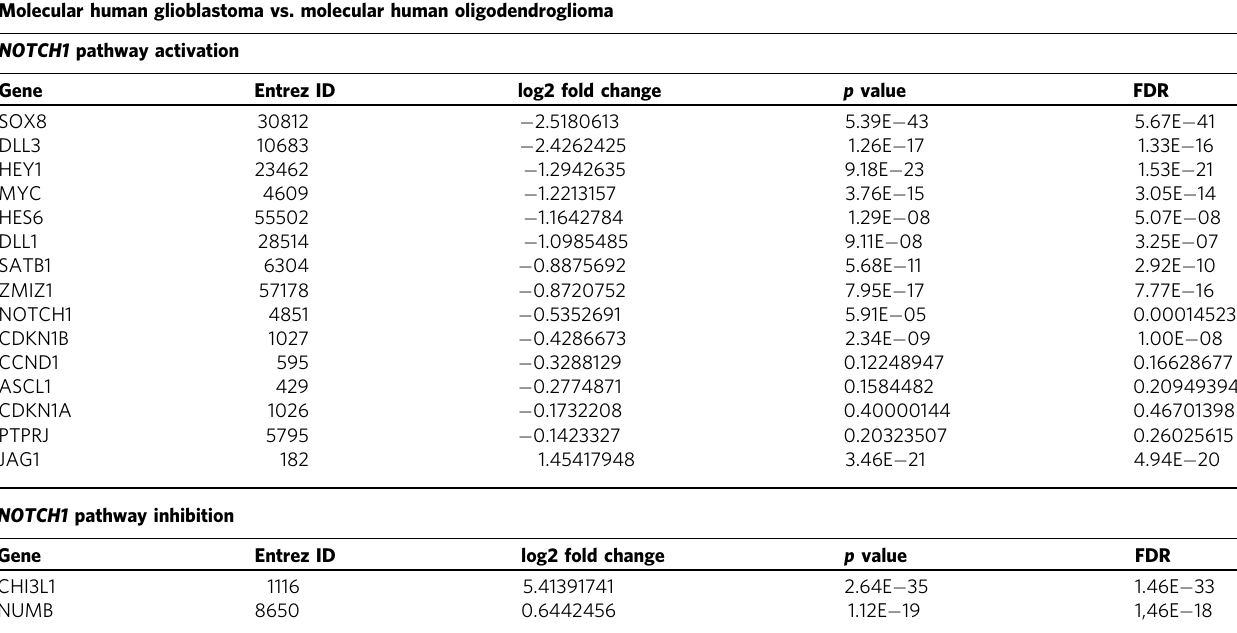
Table 2 The NOTCH1 pathway is activated in human oligodendrogliomas compared to glioblastomas. Molecular human glioblastoma vs. molecular human oligodendroglioma